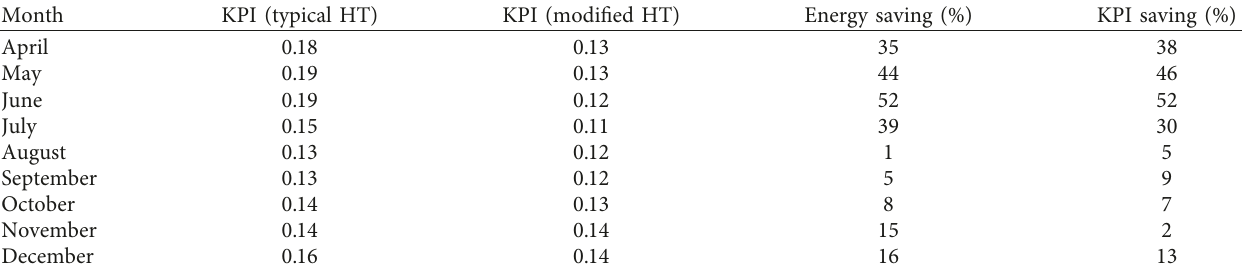
Table 5: Total energy savings expressed as key performance index (KPI) during 2015 (typical heat treatment) and 2016 (heat treatment reducing 4 ° C) and percentage savings per unit of energy.